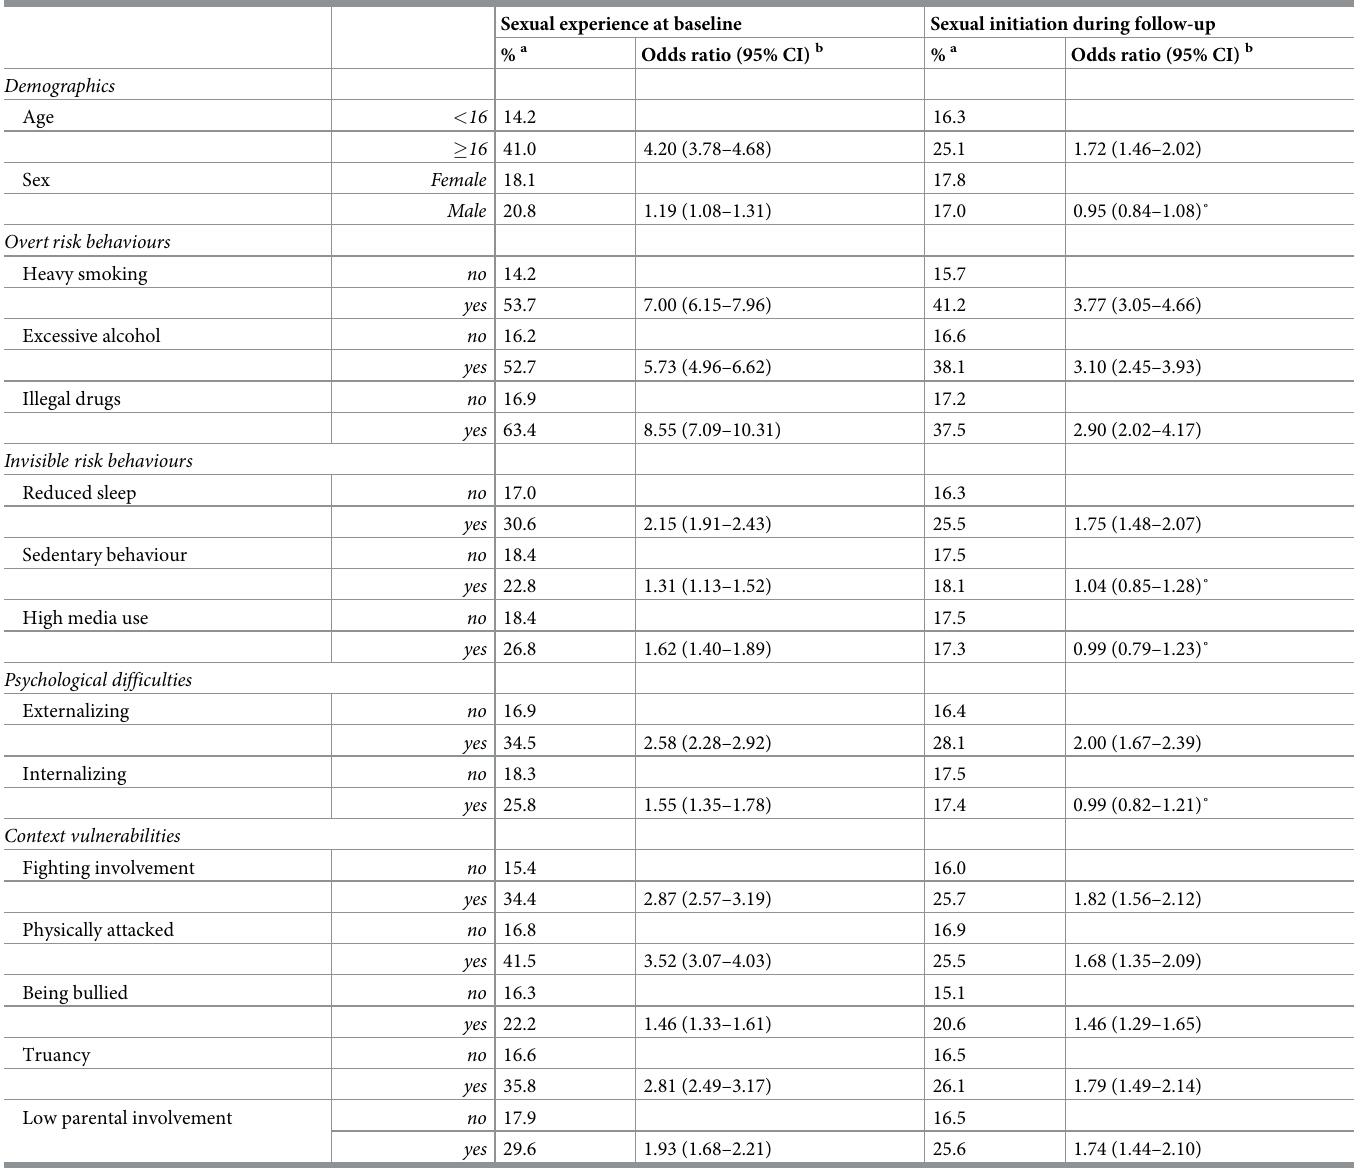
Table 2. Correlates of sexual experience at baseline and of sexual initiation during 12-month follow-up. Sexual experience at baseline Sexual initiation during